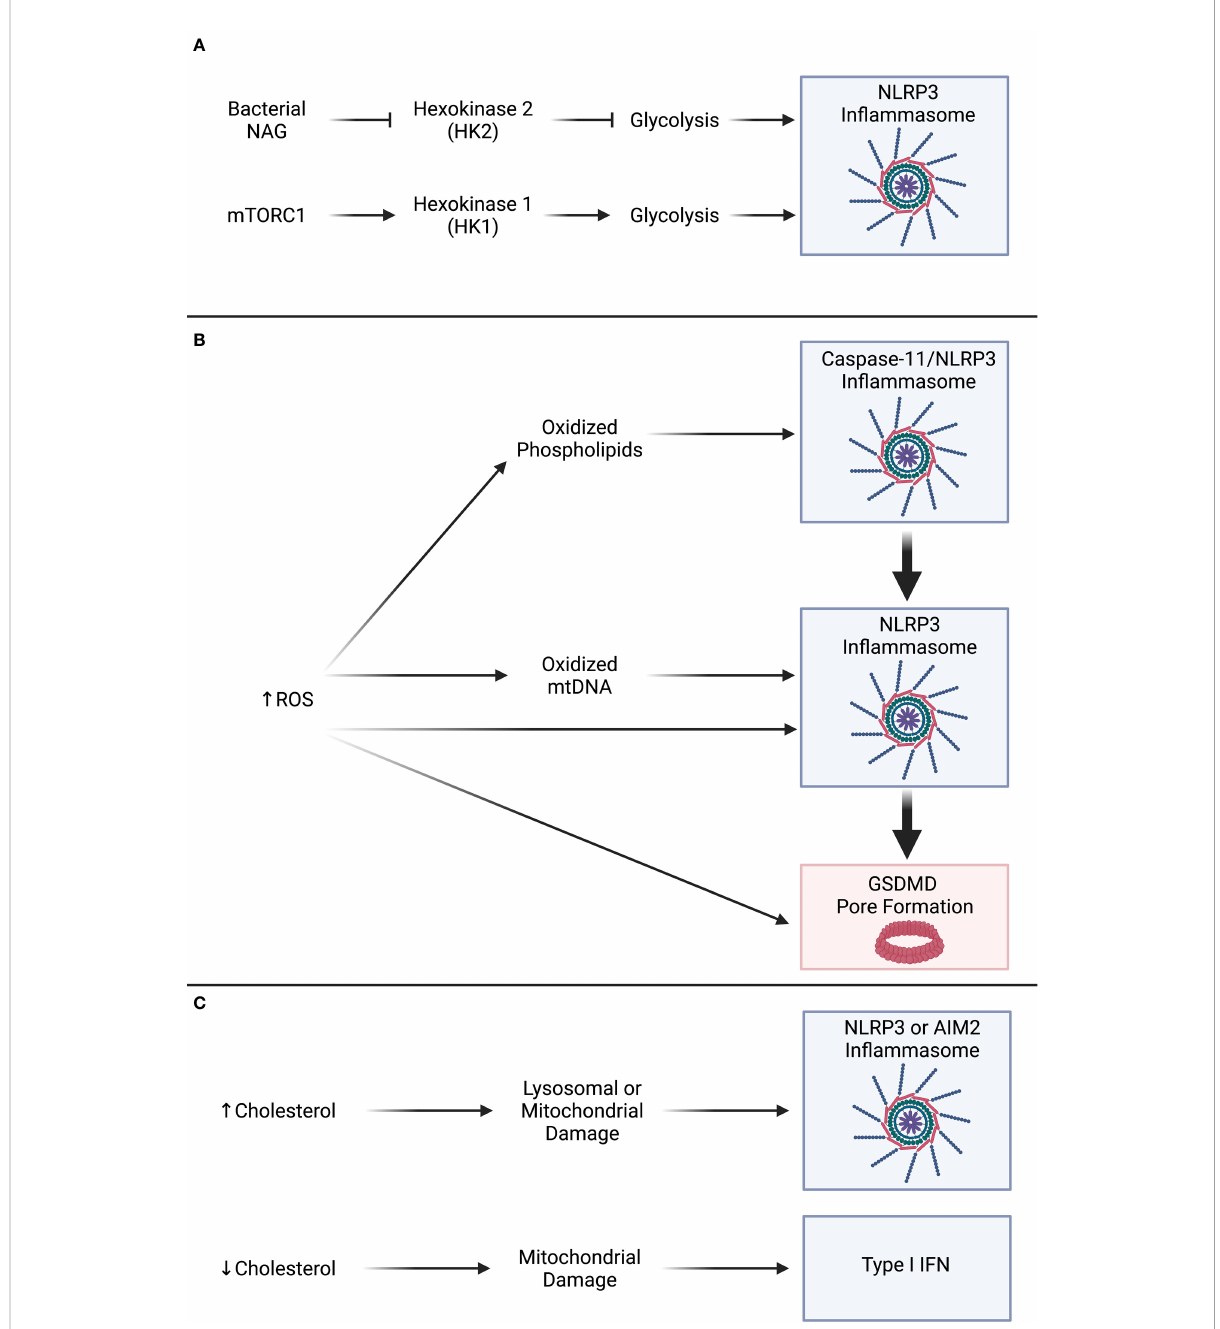
FIGURE 2 Guard circuits sense metabolic perturbations and activate in fl ammasome pathways. (A) Inhibition of glycolysis via hexokinase 2 (HK2) recognition of bacterial N-acetyl glucosamine (NAG) or activation of glycolysis via increased hexokinase 1 (HK1) activity result in NLRP3 in fl ammasome activation. (B) Increased production of reactive oxygen species (ROS) metabolites activates the NLRP3 in fl ammasome, such as through the generation of oxidized lipids, and directly promotes gasdermin D (GSDMD) pore formation. (C) Alterations to homeostatic cholesterol levels can result in lysosomal or mitochondrial dysfunction that results in in fl ammasome activation or type I interferon (IFN)